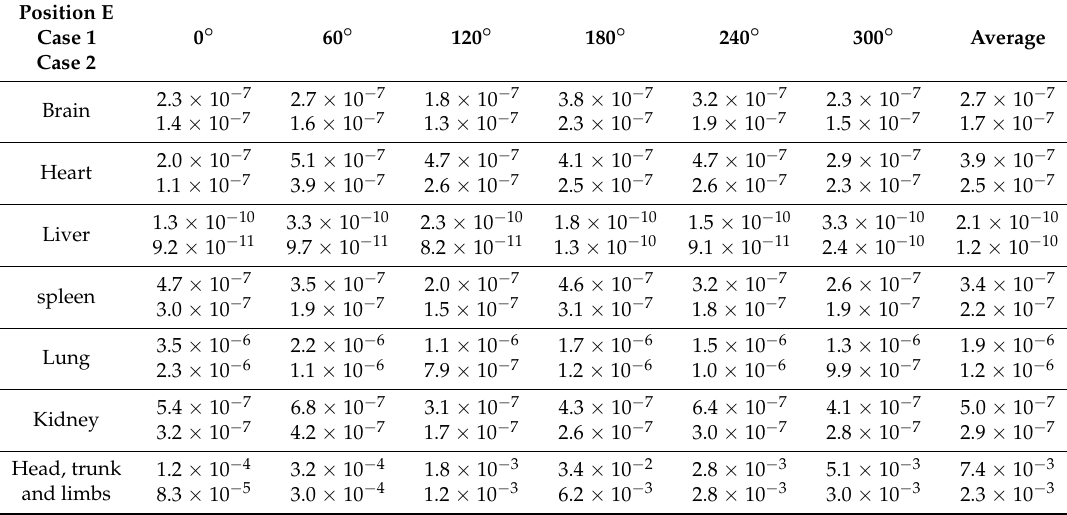
Table 8. The peak spatial-average SAR values (W/kg) in typical tissues with different orientations in position